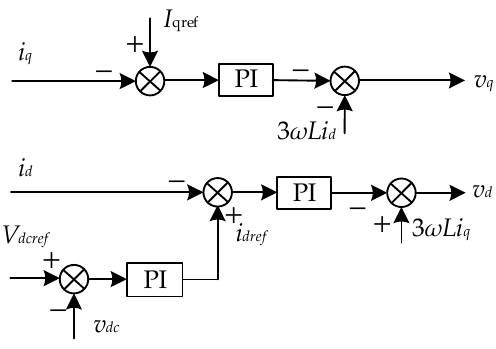
Figure 4. Control block diagram of the three-phase VSR with conventional PI control.